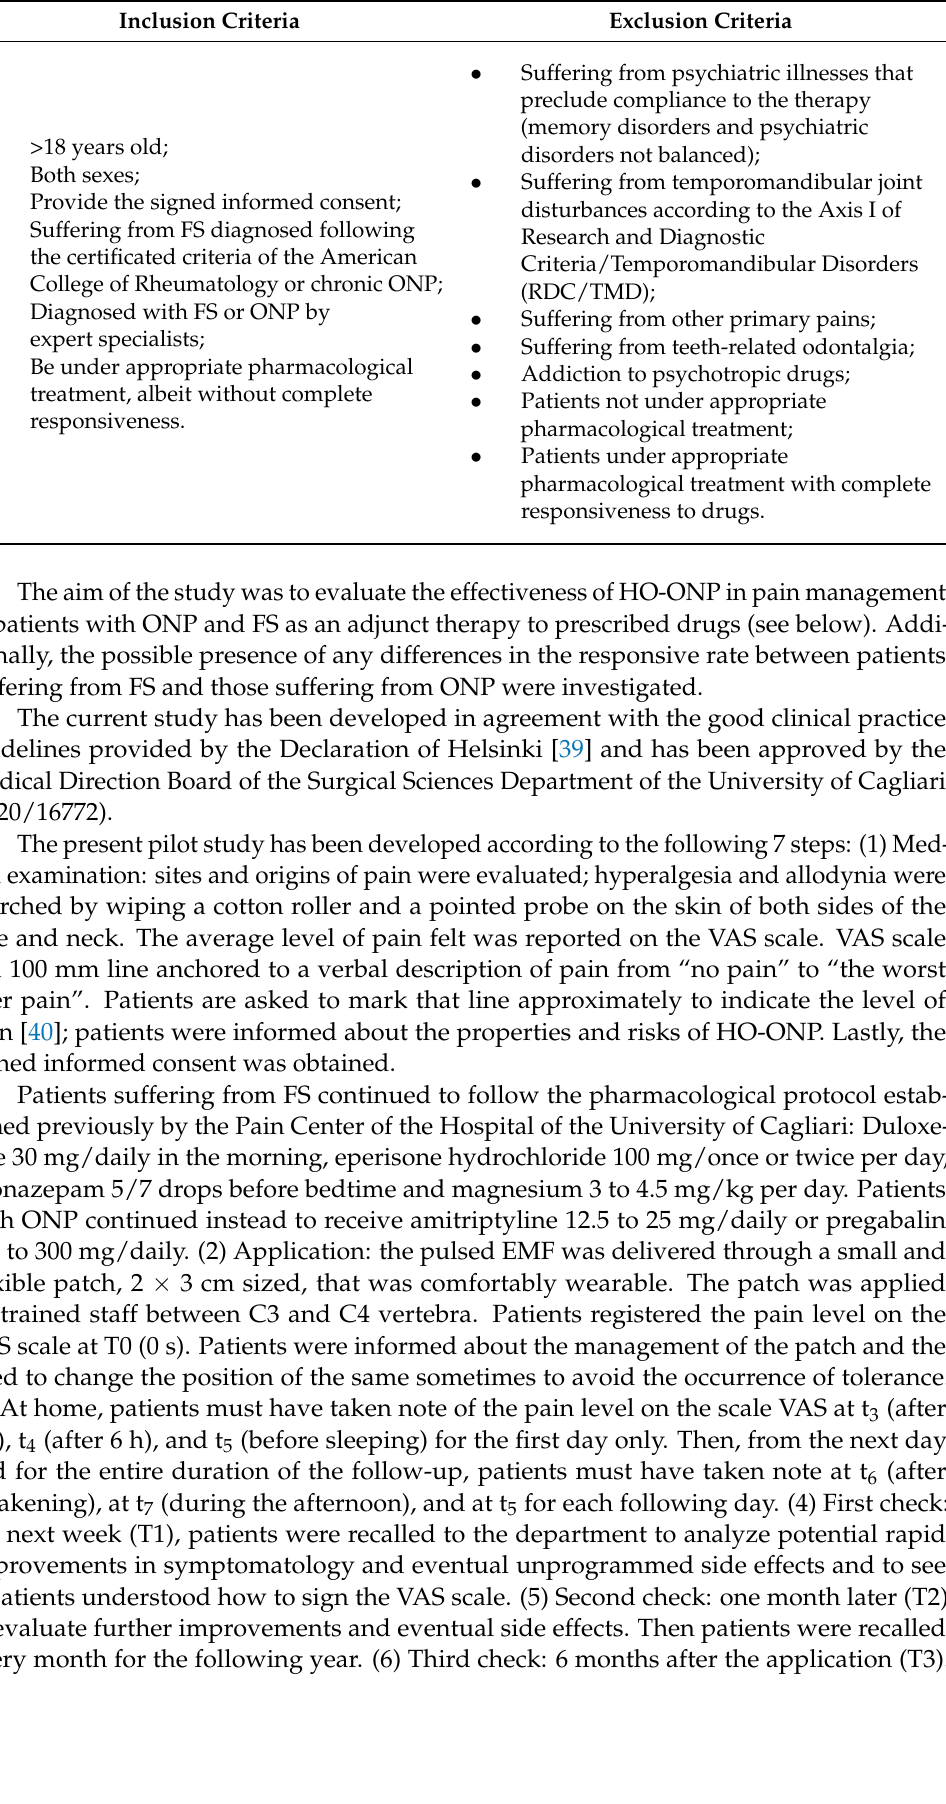
Table 1. Inclusion and exclusion